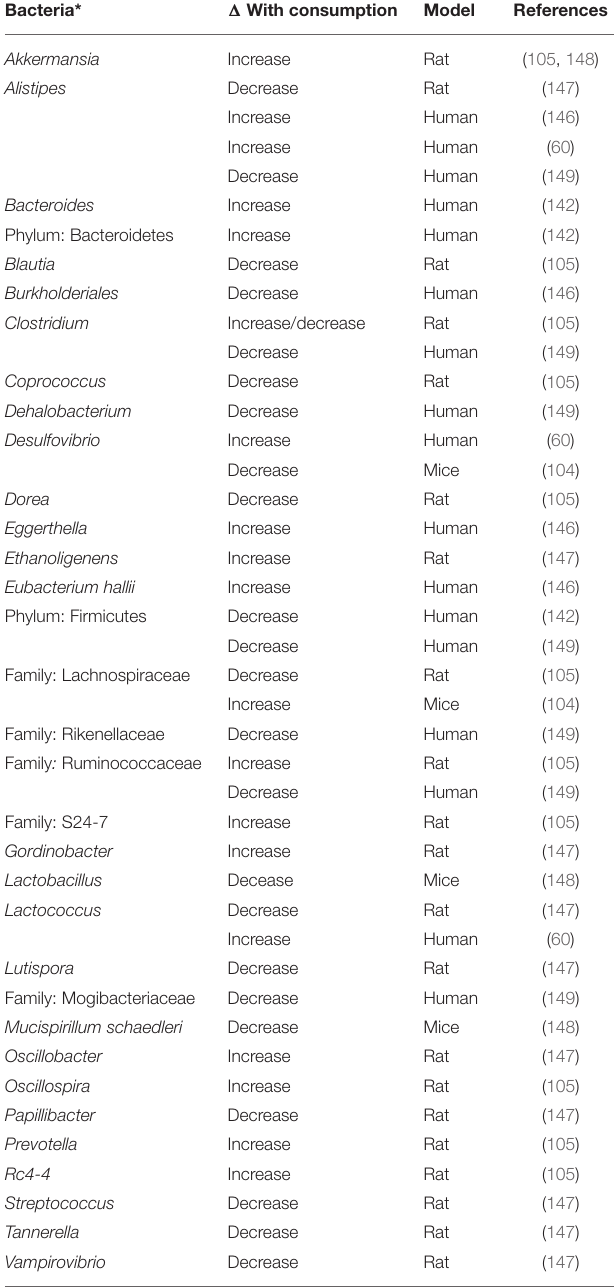
TABLE 2 | Bacteria significantly altered with cruciferous vegetable